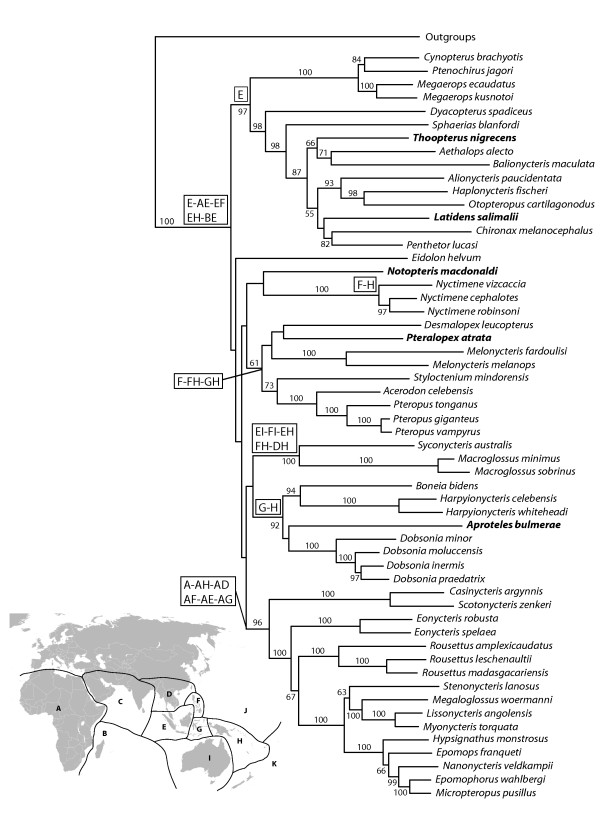
ML tree obtained with dataset 2 and partition scheme 6. Terminals in bold letters were represented in the data matrix by only two gene partitions. Bootstrap values greater than 50% are shown. Letters inside rectangles represent the inferred possible ancestral areas (labeled on the map insert and in the Additional file 9) for the referred clades.